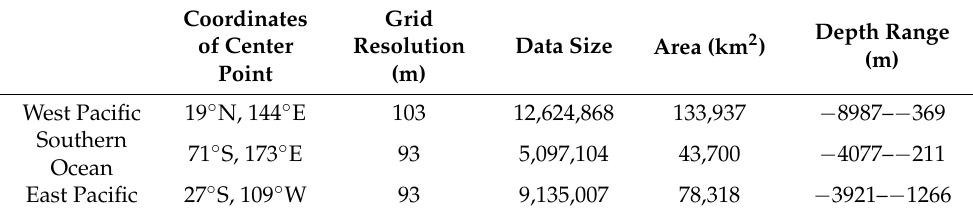
Table 1. The parameters of the acquired bathymetry data.